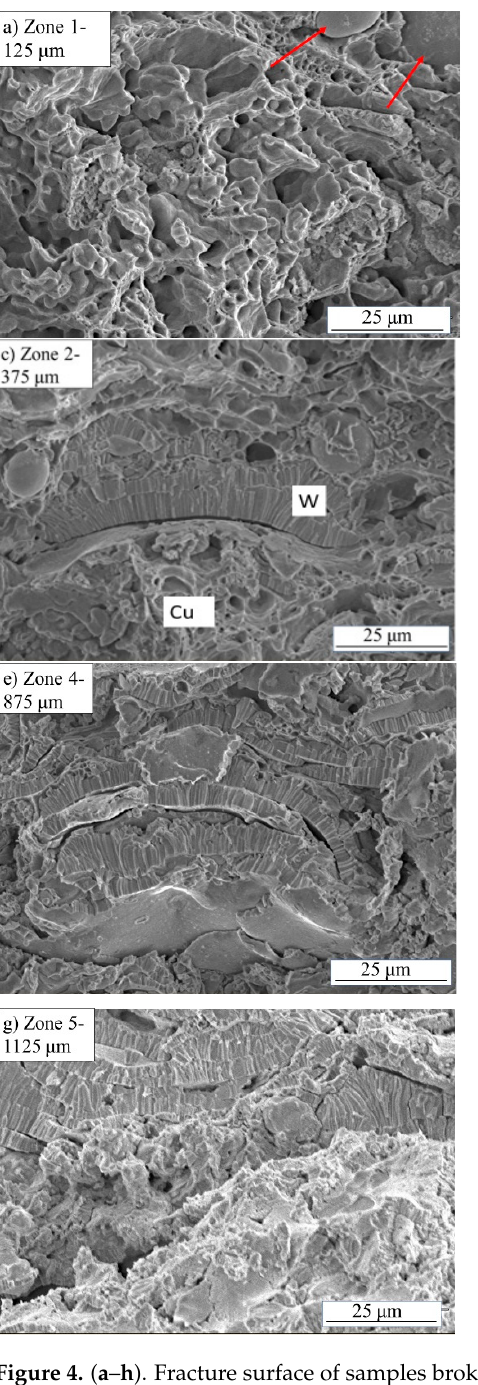
Figure 3. The stratified structure of the interlayer is shown at different magnifications in LM ( a ) and SEM ( b ) micrographs.